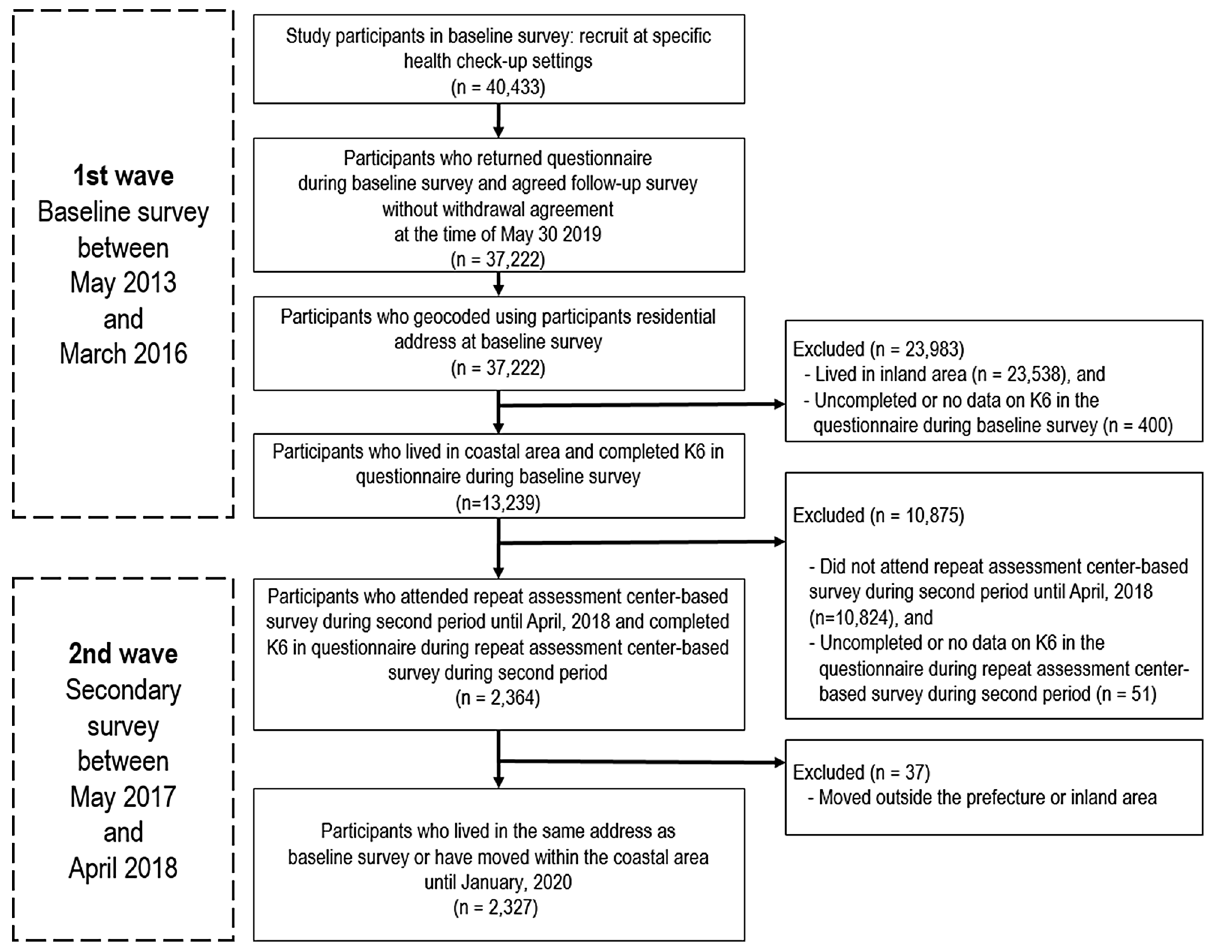
Figure 3. Flow chart for the analytical panel sample (n = 2,327) from 15 coastal municipalities, Miyagi, Japan,